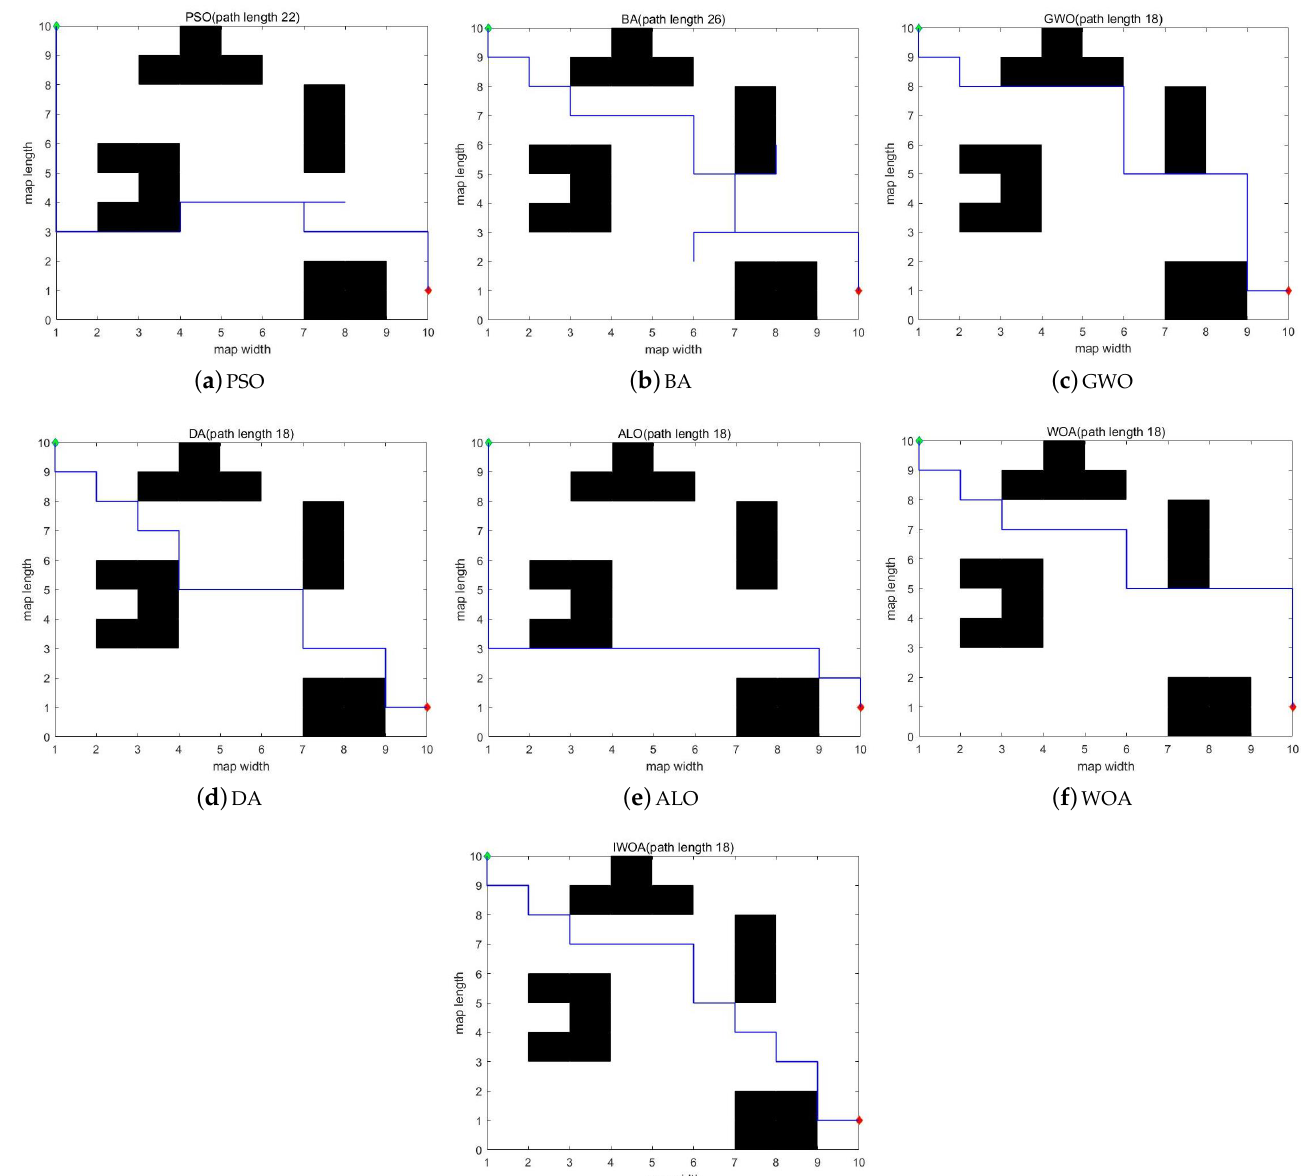
Figure 11. Actual path traces of seven different algorithms on 10 × 10 size